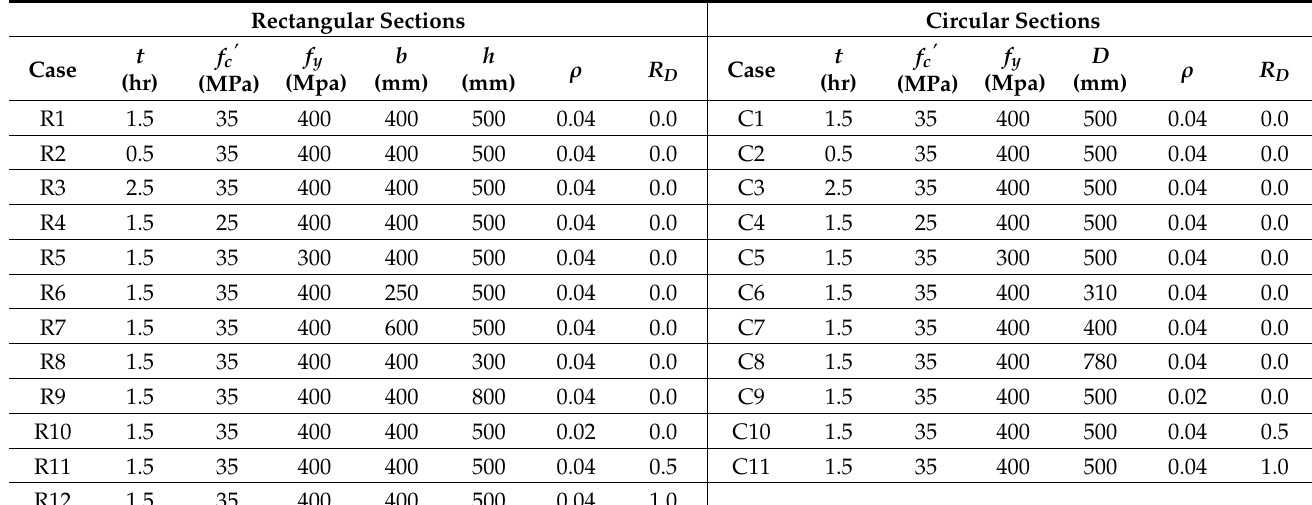
Table 1. Properties of the considered rectangular and circular column